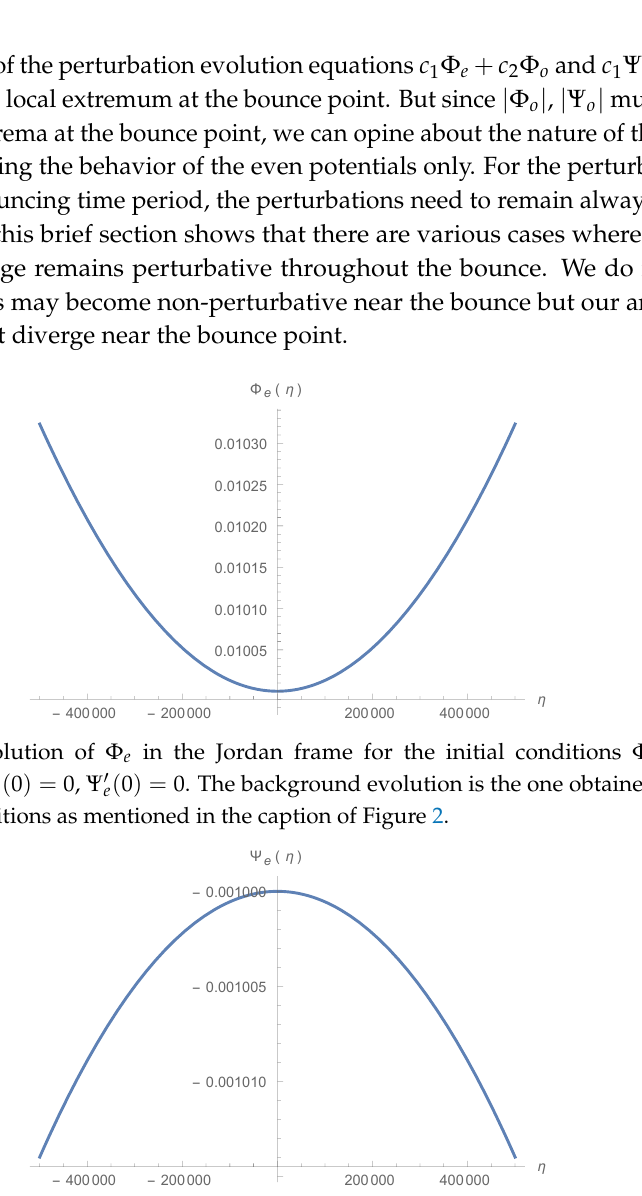
Figure 9. Time evolution of Ψ e in the Jordan frame for the initial conditions Φ e ( 0 ) = 10 − 2 , − 3 , Φ (cid:48) Ψ ( 0 ) = 0, Ψ (cid:48) ( 0 ) = 0. The background evolution is the one obtained by assuming e ( 0 ) = − 10 e e